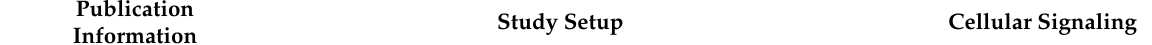
Table 6. In vivo results related to PFAS exposures and cellular signaling pathways.